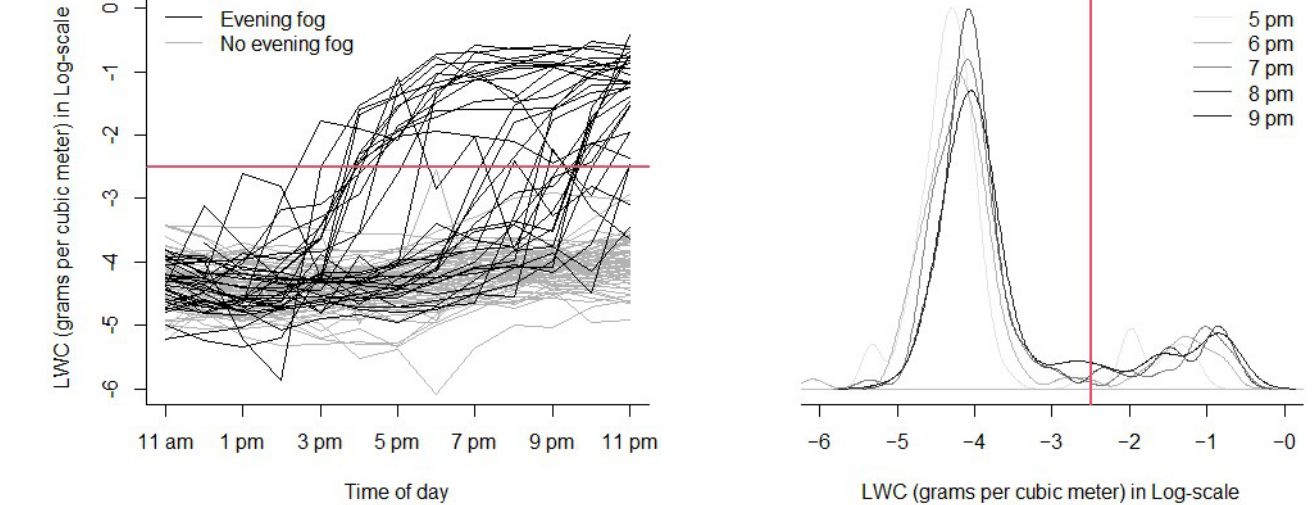
Figure 2. The daily trend of LWC ( left ) and the observed distribution of LWC(t) from t = 17 to t = 21 ( right ), observed from 29 July to 6 November 2020. The red line represents the threshold above which fog is defined to be present. This paper used a slightly lower threshold of log(LWC) = −2.5.